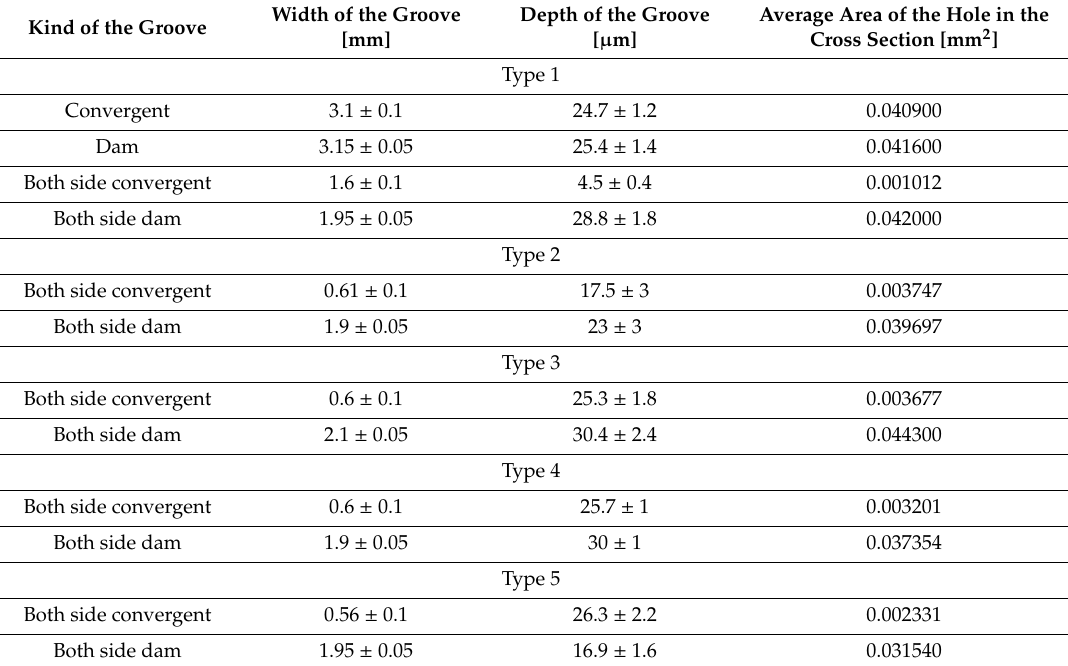
Figure 6. Isometric views of grooves from discs of type 2: both side dam ( left ) and both side convergent ( right ). Table 1. Sizes of grooves from various textured